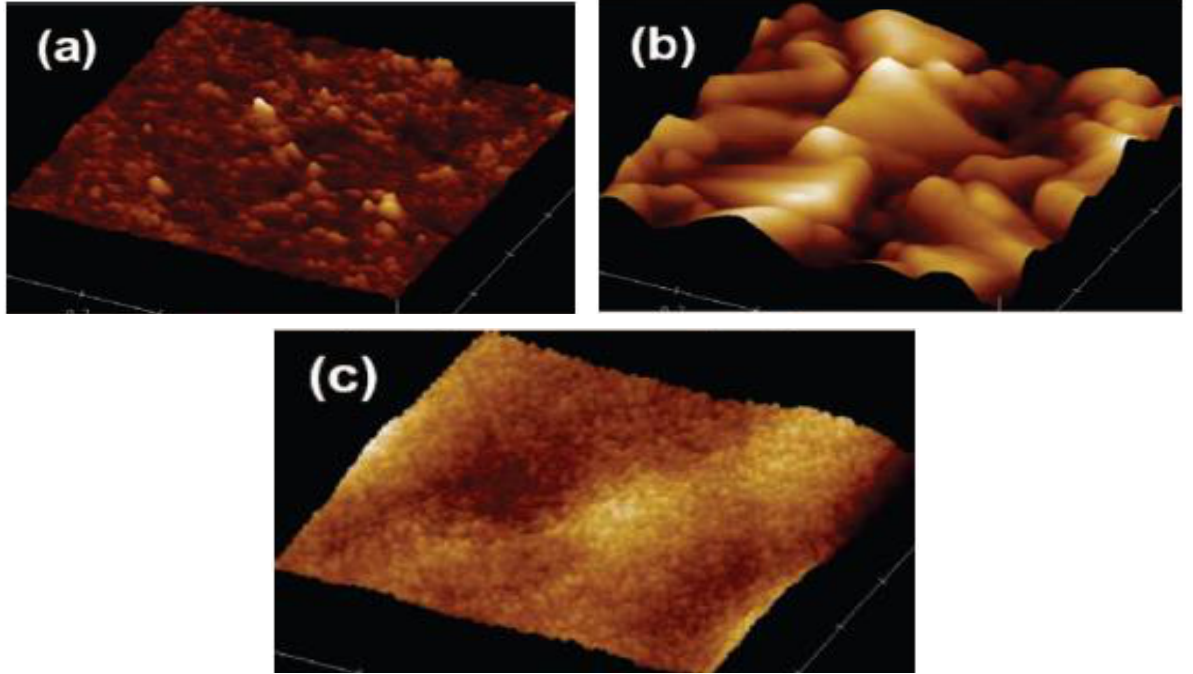
Figure 18. AFM images of ( a ) bare Pyrex glass; ( b ) FTO layer; and ( c ) Meso-TiO Reprinted with permission from [48]. Copyright 2008 American Chemical